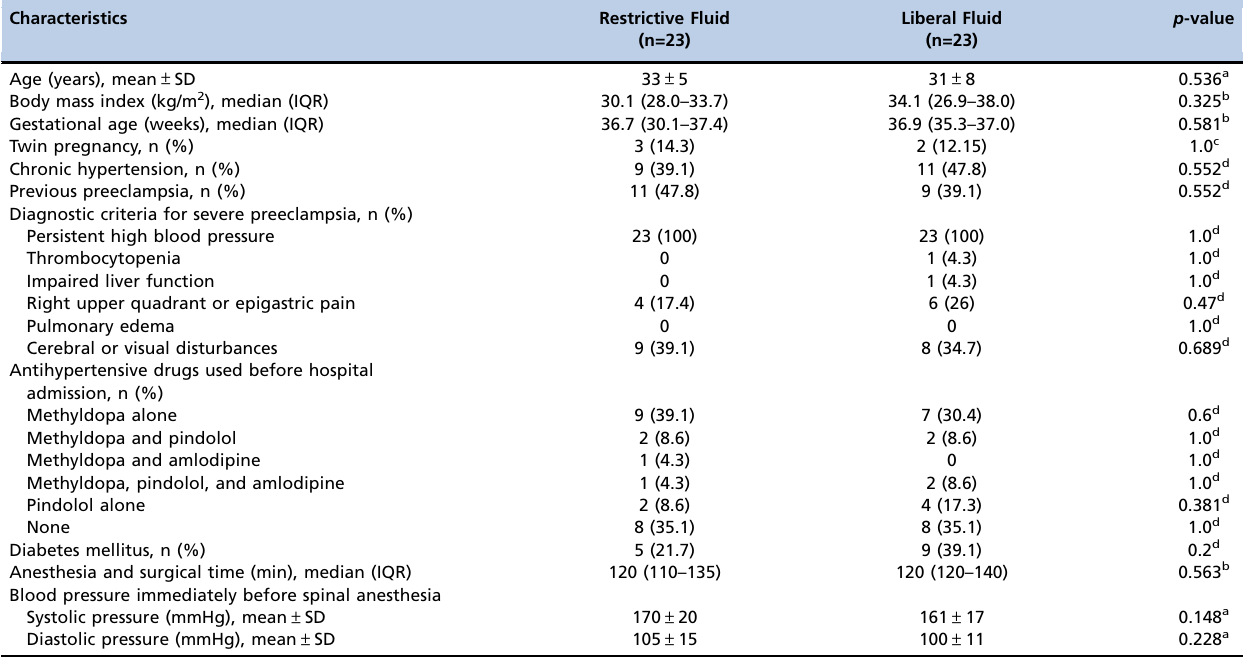
Table 1 - Demographic and clinical characteristics of patients at baseline. Characteristics